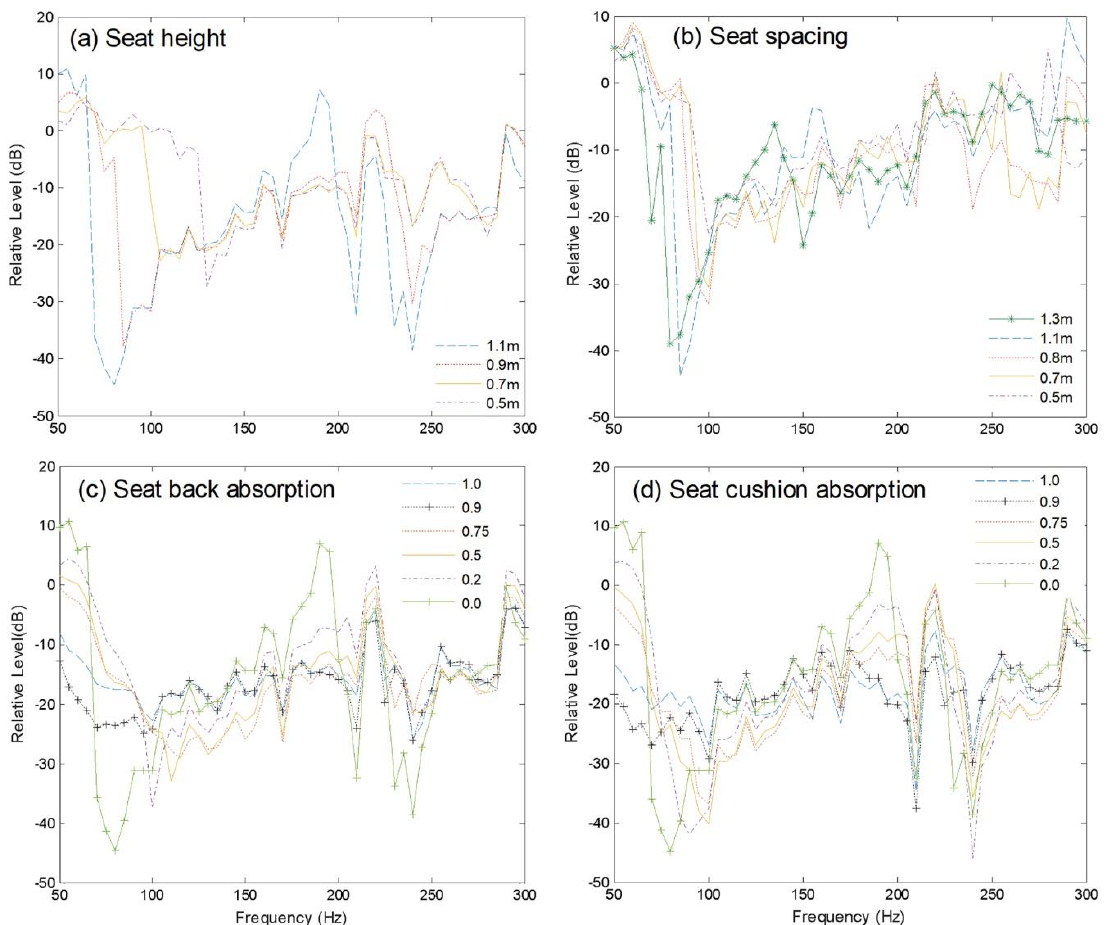
Figure 4. Spectra of average RL at receivers R4-R6 for investigation of influence on the SDE from ( a ) seat heights ( w = 0.8 m, seats and floor are rigid); ( b ) seat spacing ( h = 0.8 m, seats and floor are rigid); ( c ) seat back absorption ( h = 1.1 m and w = 0.8 m) and ( d ) seat cushion absorption ( h = 1.1 m and w = 0.8 m).